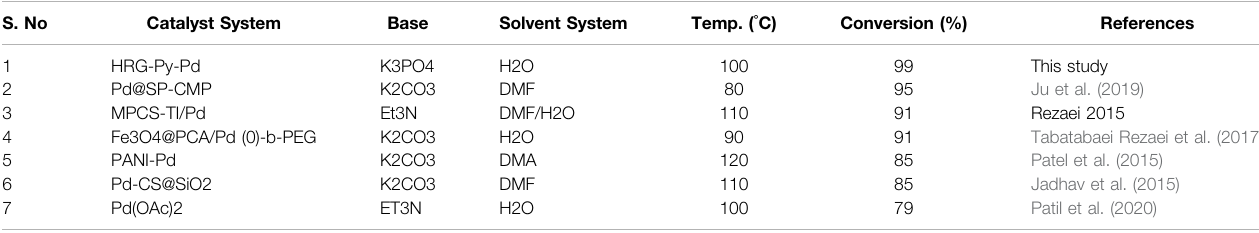
TABLE 4 | Comparison of the results obtained with the HRG-Py-Pd nanocatalyst for the Mizoroki-Heck reaction of 4-bromoanisol and acrylic acid in an aqueous solution with previously reported results in the literature. S. No